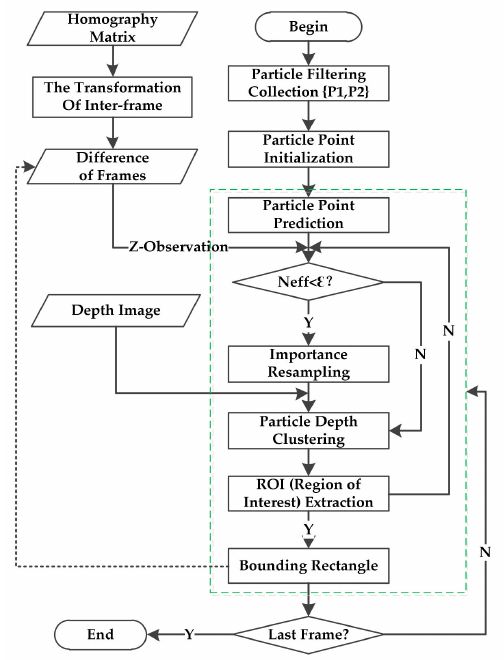
Figure 6. A flowchart of the dynamic objects segmentation